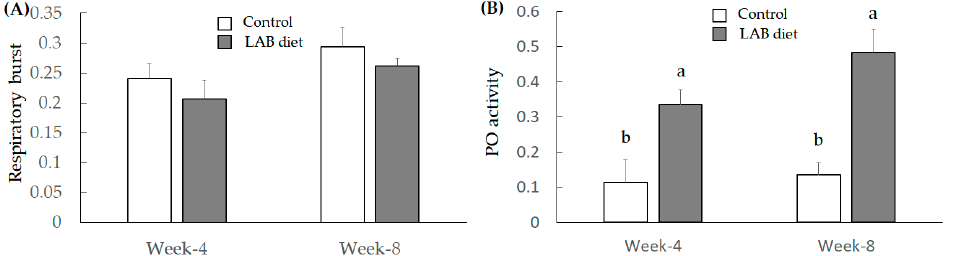
Figure 1. The variations of THC ( A ), granular cells ( B ), semi-granular cells ( C ), and hyaline cells ( D ) in shrimp feed with control or LAB feed. Significant difference is shown by different letters (a, b) ( p < 0.05) between control and LAB feed groups.